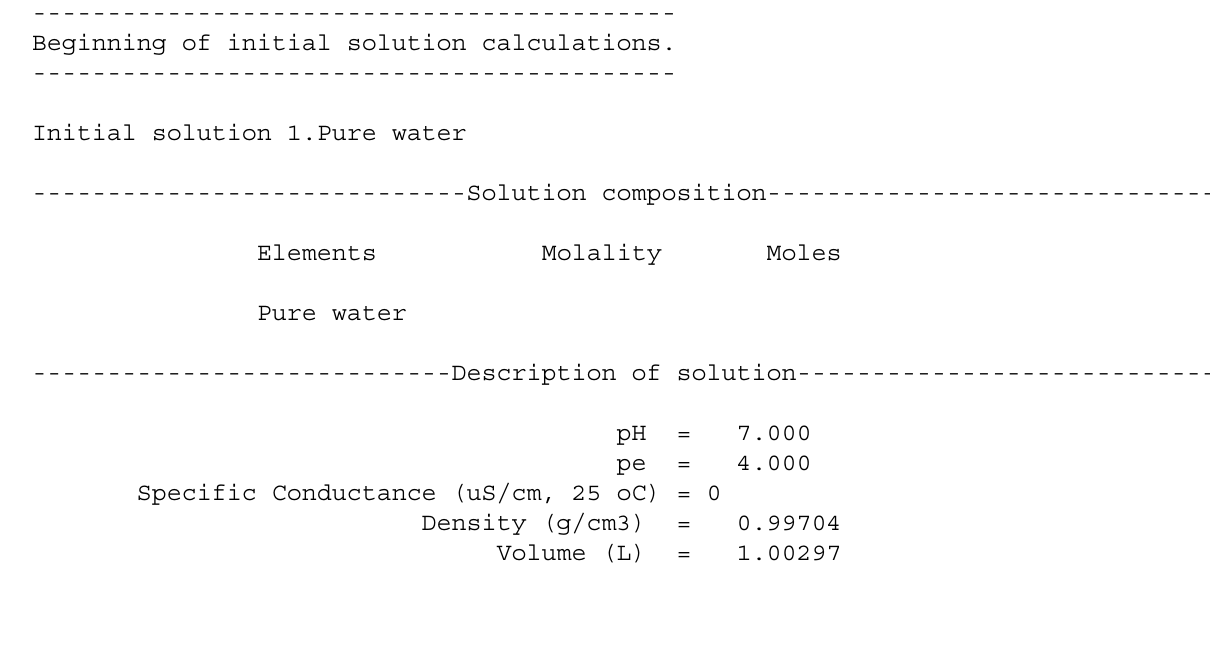
Table 13. Selected output for example 2. ------------------------------------------- Beginning of initial solution